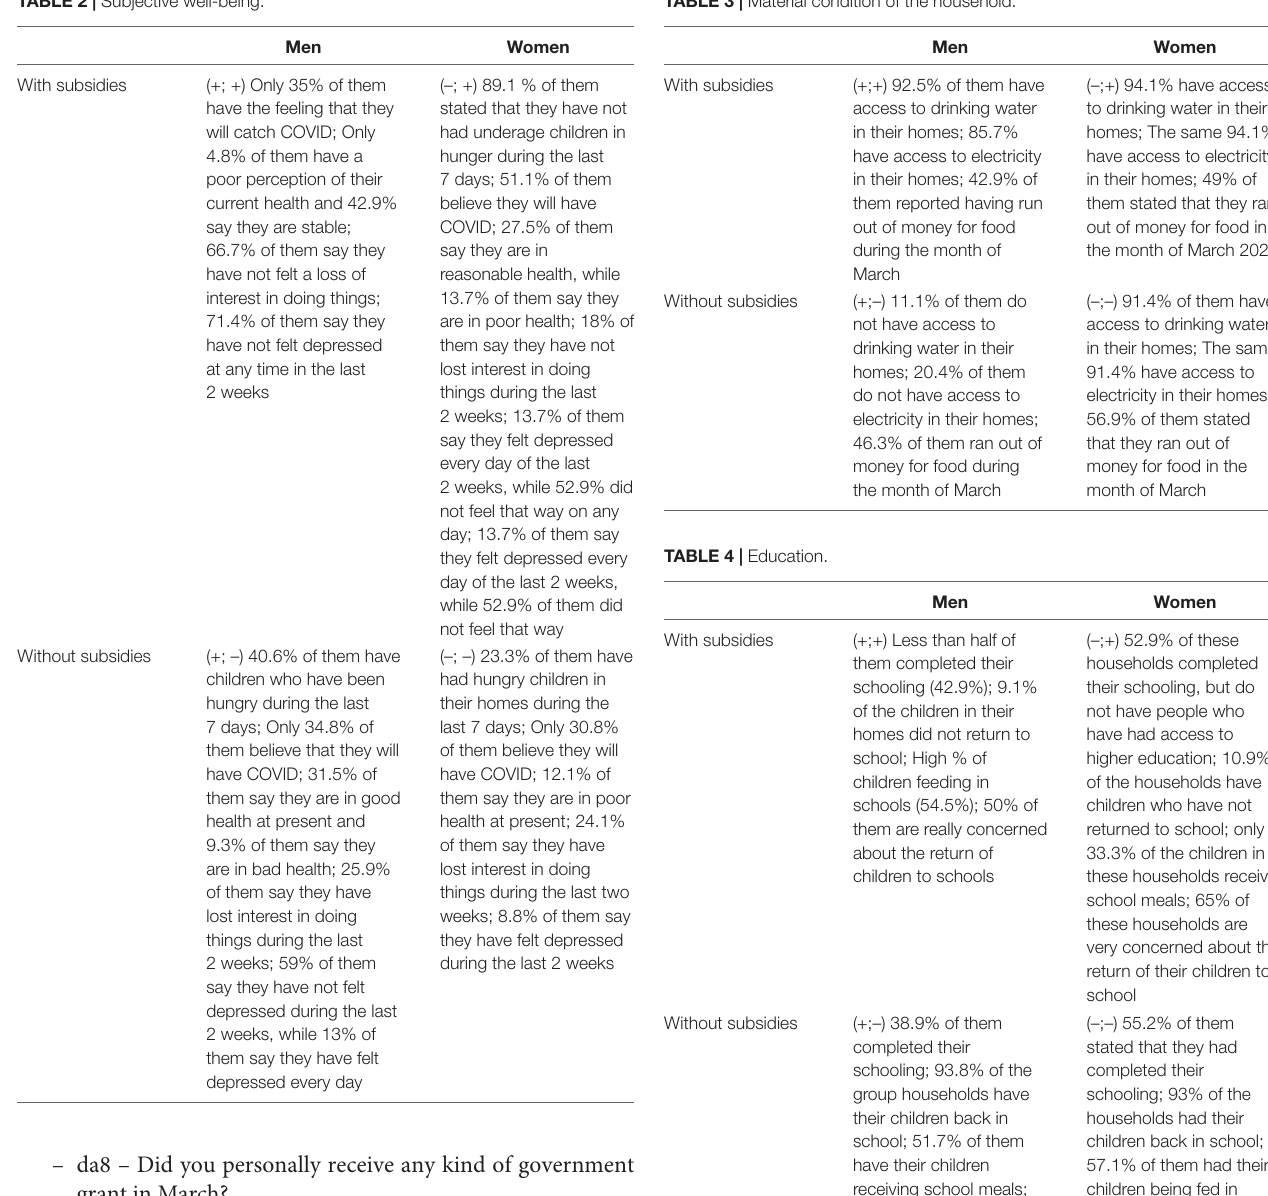
TABLE 2 | Subjective well-being.